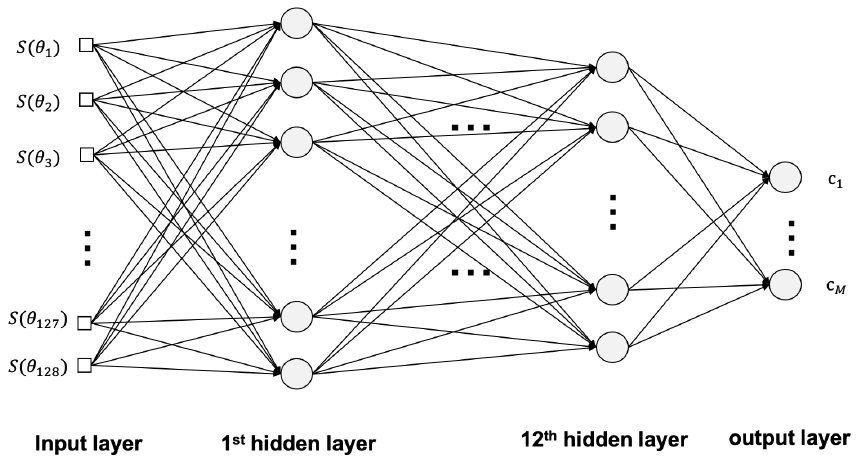
Figure 1. The architecture of a multilayer perceptron with 12 hidden layers. A total of 12,000 numerical data sets with R = 1, N = 8, M = 5 were separated into 8000 training data sets, 2000 development data sets, and 2000 evaluation data sets. All training was performed using an NVIDIA Quadro P4000.